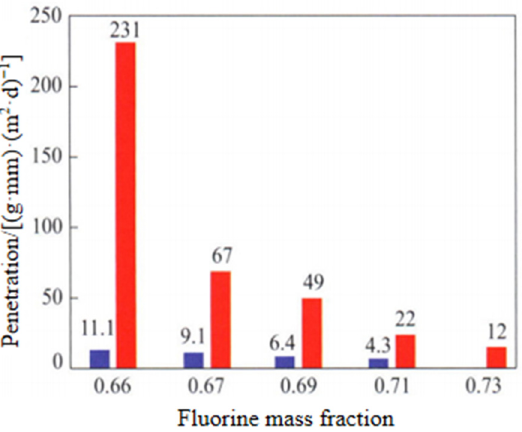
Figure 13. Effect of fluorine contents on low temperature resistance and methanol resistance of nuoroelastomers.